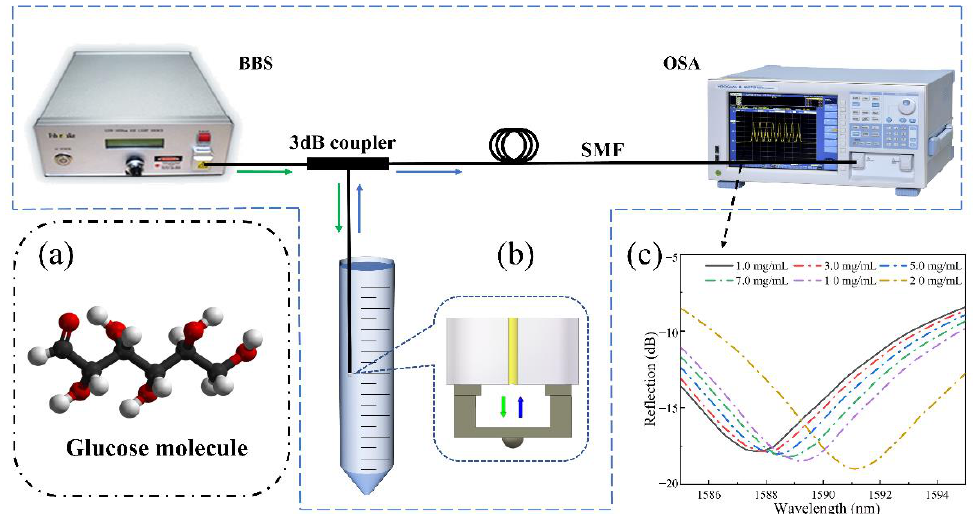
Figure 6. The sensing system is based on a fiber end-face fixed-supported bridge for measur- ing the glucose concentration: ( a ) A glucose molecular diagram. ( b ) A schematic diagram of the glucose solution detection system. ( c ) Reflection spectrum drift as a function of the measured glucose